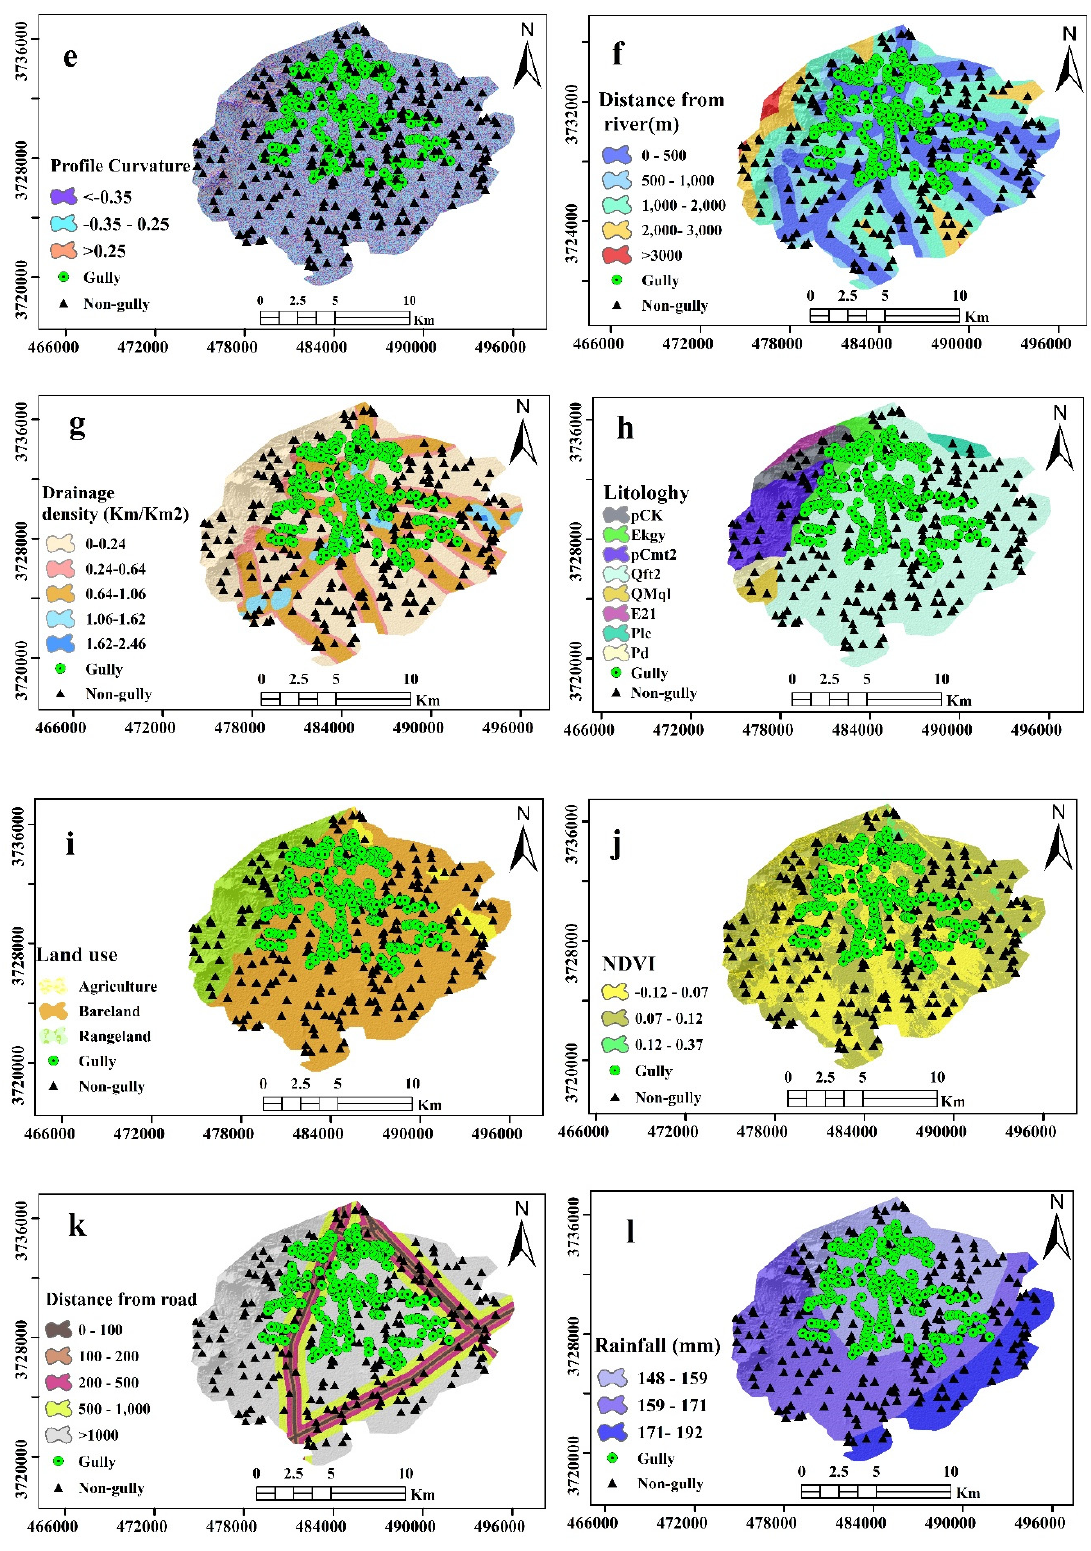
Figure 4. Gully erosion geo-environment factor maps of the study area: ( a ) DEM, ( b ) slope degree, ( c ) slope aspect, ( d ) plan curvature, ( e ) profile curvature, ( f ) distance to rivers, ( g ) drainage density, ( h ) lithology, ( i ) land use, ( j ) NDVI, ( k ) distance to roads, and ( l ) annual mean rainfall.